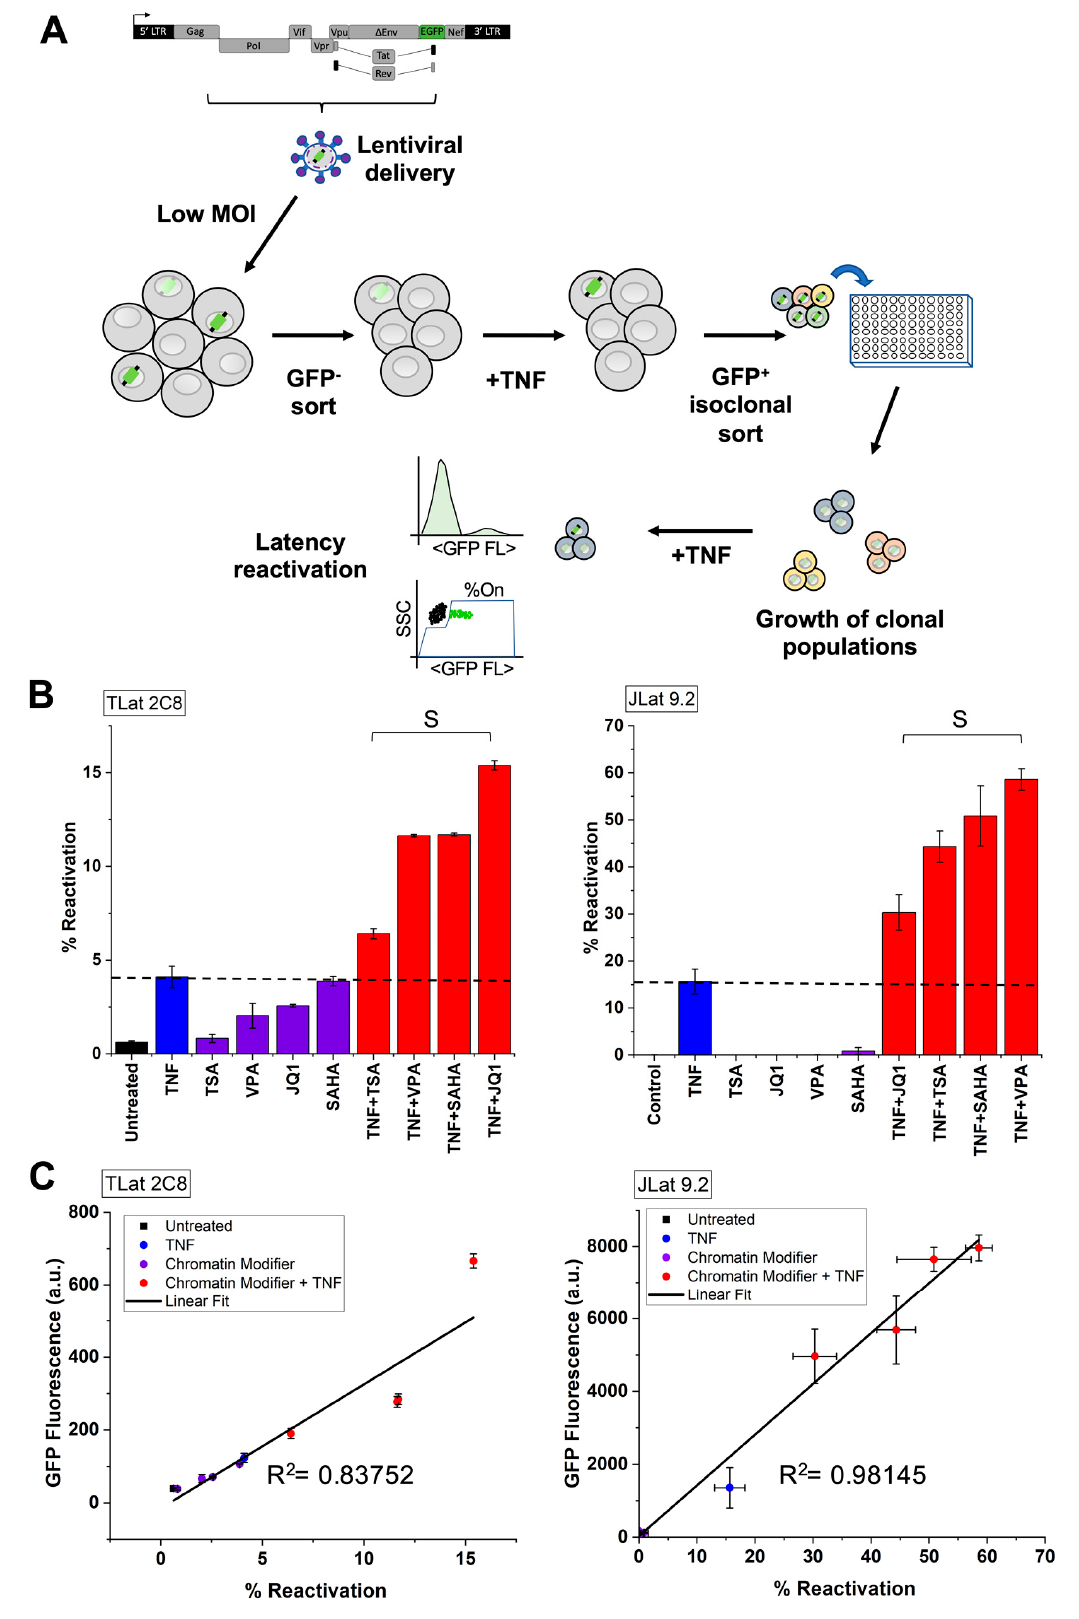
Figure 3. Chromatin modifiers synergize with TNF to enhance reactivation from latency in an HIV latently-infected monocytic cell line. ( A ) A full-length HIV retroviral vector expressing enhanced GFP (EGFP) (NL4-3 ∆ Env EGFP